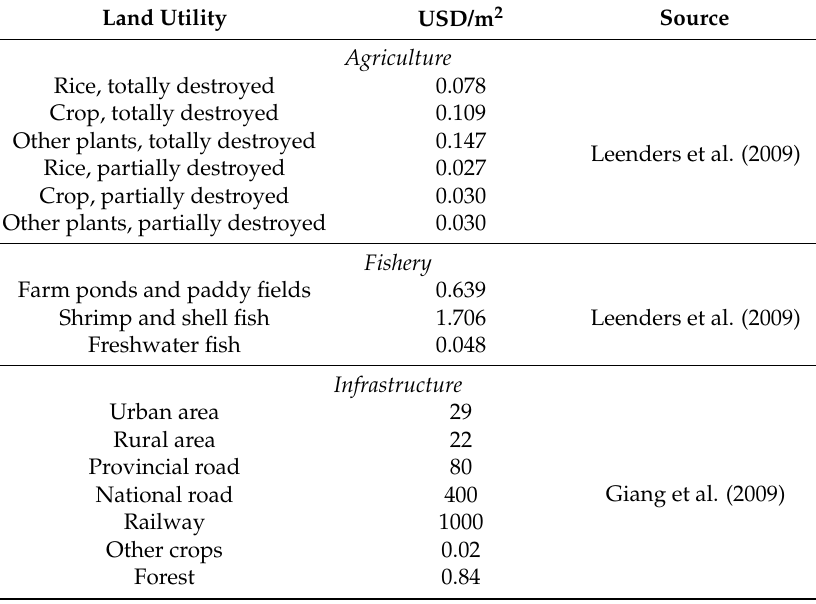
Table 1. Maximum damage values ( S i ) used in this